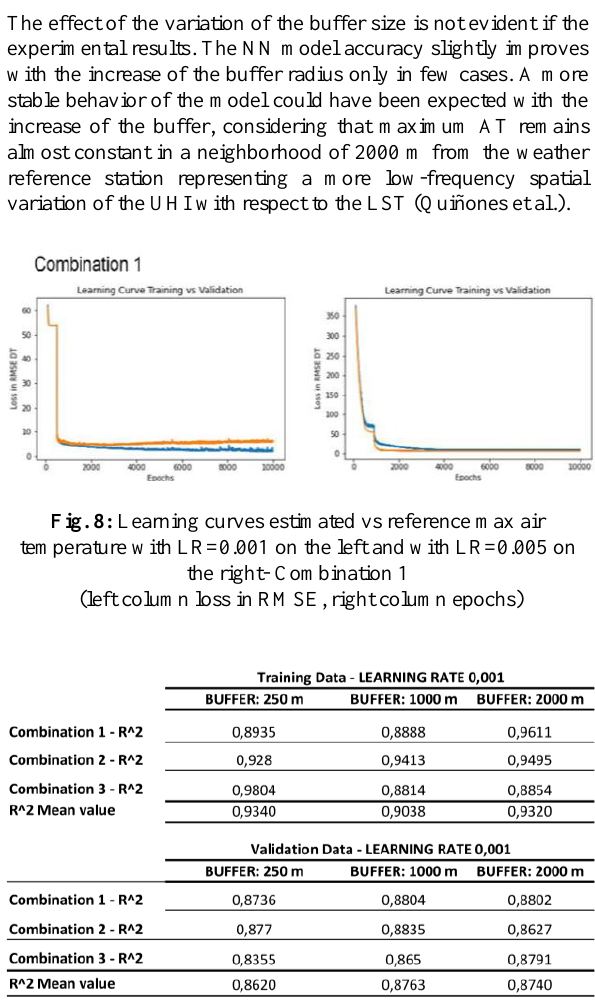
Tab. 1: Training and validation values of R^2 over the K-folds using Learning Rate 0.001.